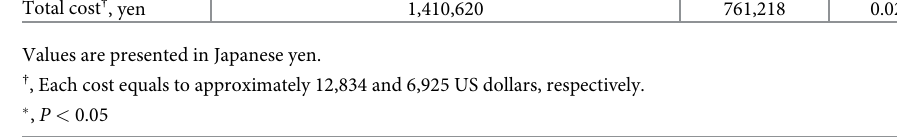
Table 5. Comparison of total cost between inflammation extend to rectovesical excavation group and the other group (n = 203). Inflammation extend to rectovesical excavation (n = 22) Total cost † , yen 761,218 Values are presented in Japanese yen.